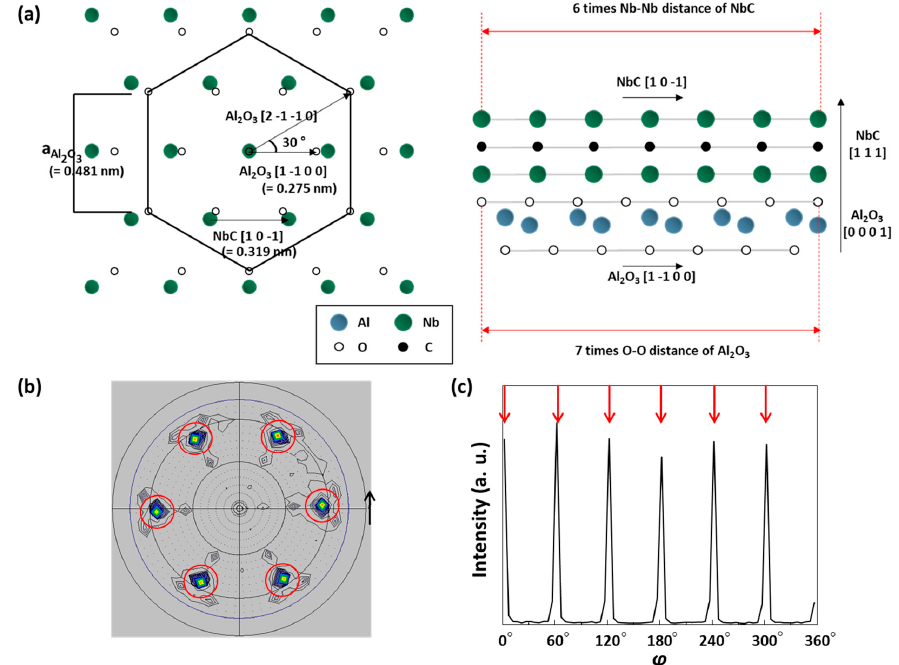
Figure 4. ( a ) Schematic diagrams showing the epitaxial relationship between the (0001) plane of the c -plane sapphire (Al 2 O 3 ) substrate and NbC (111) plane: Top (left) and side views (right); ( b ) X-ray pole figure of the NbC/ c -sapphire system measured at a 2 θ angle of 40.32 ◦ for the NbC (200) peak; ( c ) Azimuthal ( ϕ ) scan data measured at a χ angle of 55 ◦